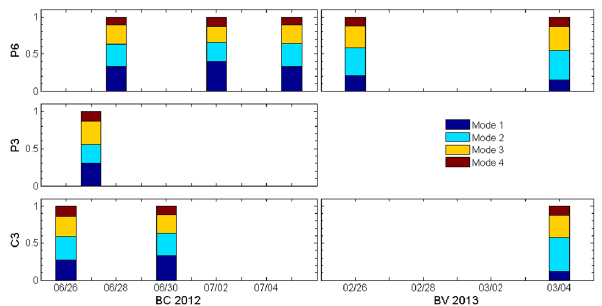
Figure 3. Number fraction of DMPS lognormal modes from micro- layer enriched samples (SS = 0.39%) at BC and BV.